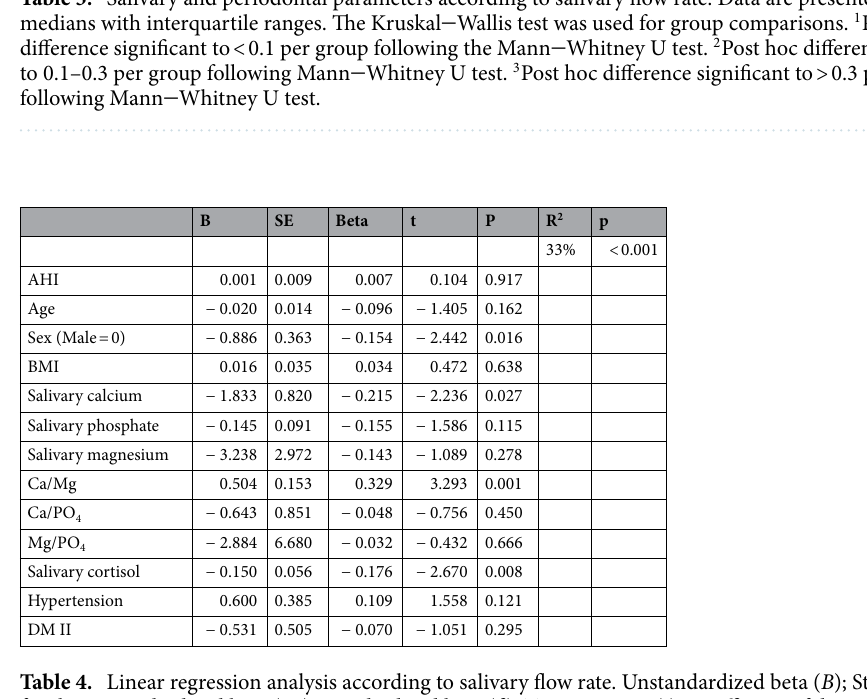
Table 4. Linear regression analysis according to salivary flow rate. Unstandardized beta ( B ); Standard error for the unstandardized beta ( SE ); Standardized beta ( β ); T-test statistic ( t ); Coefficient of determination ( R 2 ); Probability value ( p